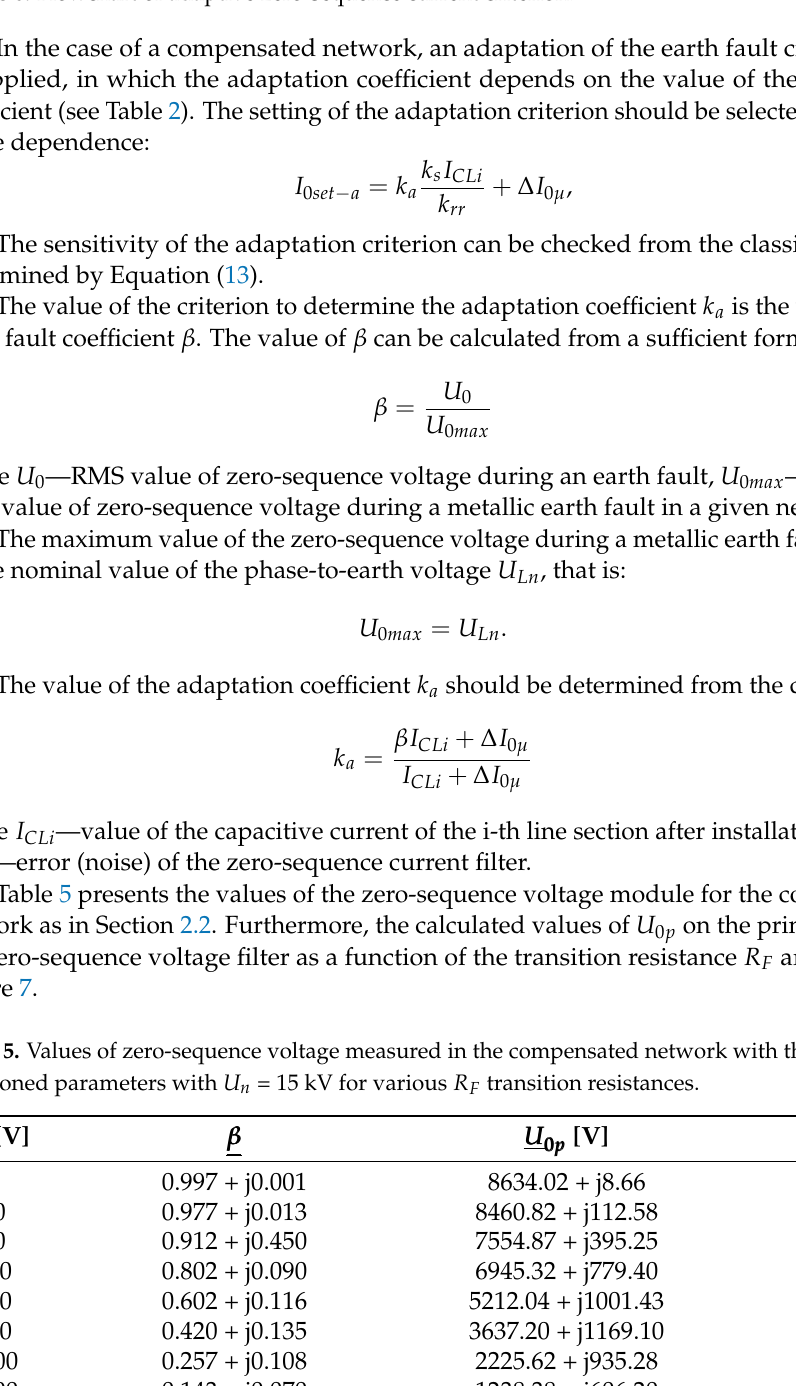
Figure 6. Flowchart of adaptive zero-sequence current criterion.